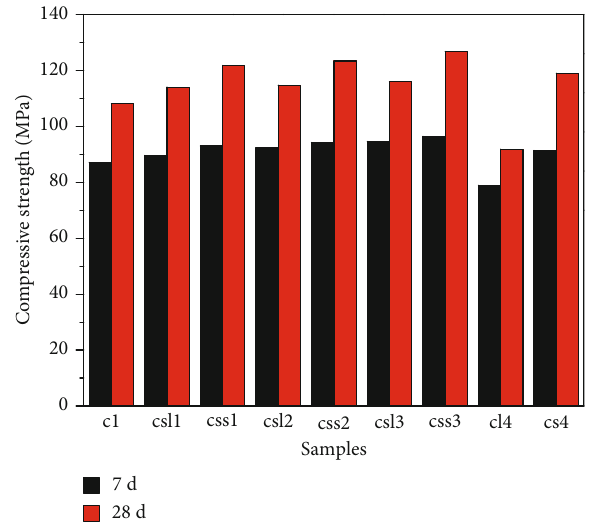
Figure 6: Comparison of compressive